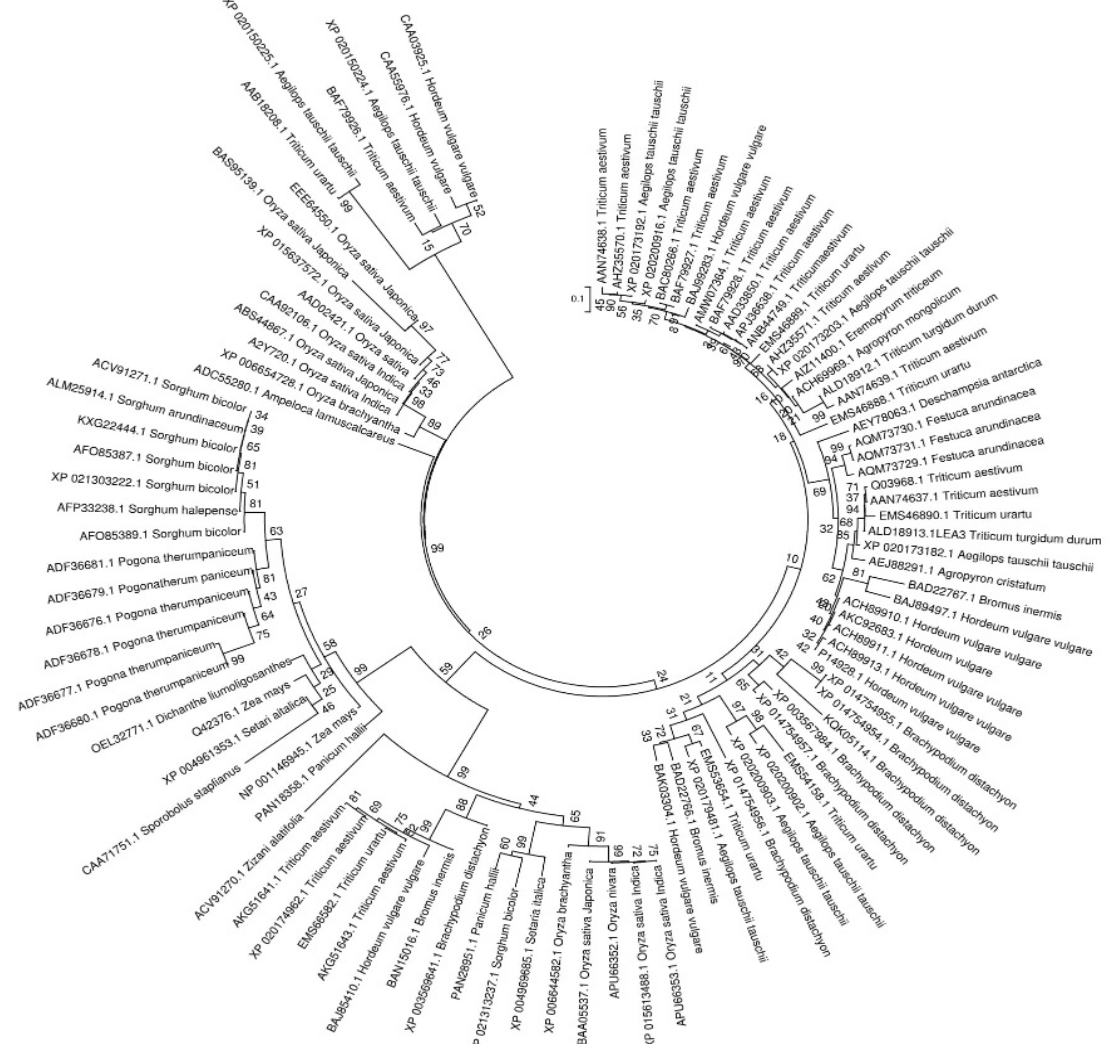
Fig. 3. Evolutionary relationships of LEA protein sequences: The evolutionary history was inferred using the Neighbor- Joining method (Saitou et al., 1987). The optimal unrooted tree with the sum of branch length = 8.92617397 is shown. The percentage of replicate trees in which the associated taxa clustered together in the bootstrap test (500 replicates) are shown next to the branches (Felsenstein, 1985). The tree is drawn to scale, with branch lengths in the same units as those of the evolutionary distances used to infer the phylogenetic tree. The evolutionary distances were computed using the JTT matrix-based method (Jones et al., 1992) and are in the units of the number of amino acid substitutions per site. The rate variation among sites was modeled with a gamma distribution (shape parameter = 1). The analysis involved 100 amino acid sequences. All ambiguous positions were removed from each sequence pair. There were 450 positions in the final dataset. Evolutionary analyses were conducted in MEGA7 (Kumar et al.,